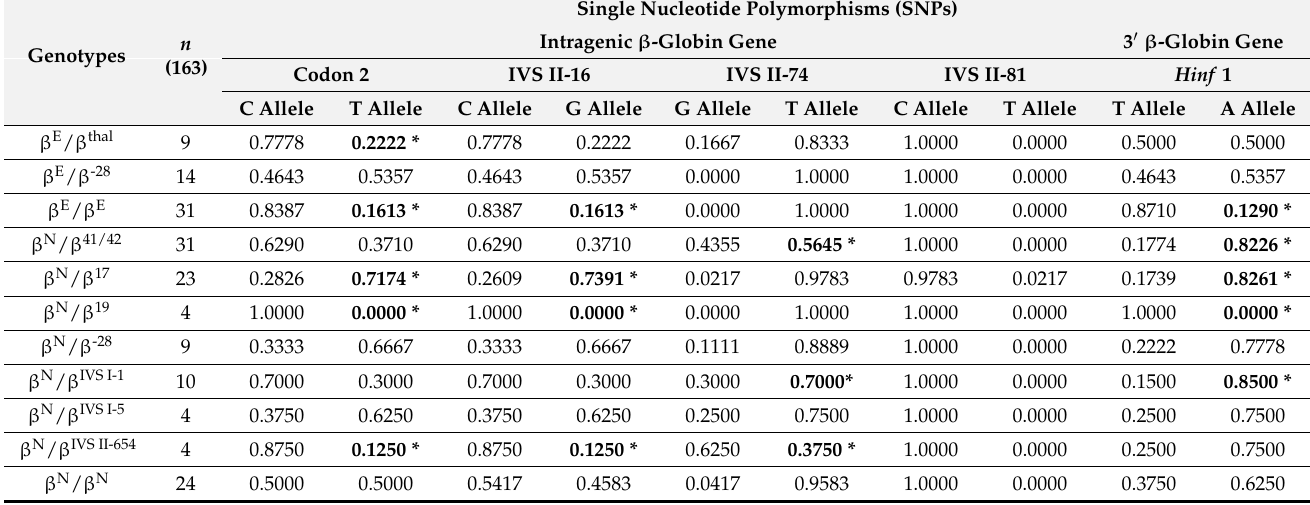
Table 2. Allele frequencies of five single nucleotide polymorphisms on intragenic β -globin gene and 3 (cid:48) β -globin gene in different 11 β -thalassemia genotypes in Thai population. First and sec- ond allele columns indicate ancestral allele and derived allele, respectively. Bold text with super- script * indicates Fisher’s exact test revealed DAF significant difference between wild type and β -thalassemia